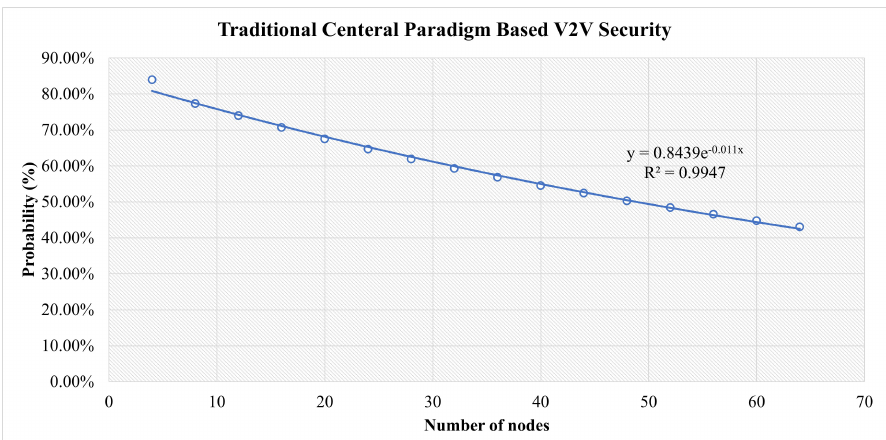
Figure 10. Results for All Three Categories of Attacks in the Traditional Central-Based V2V